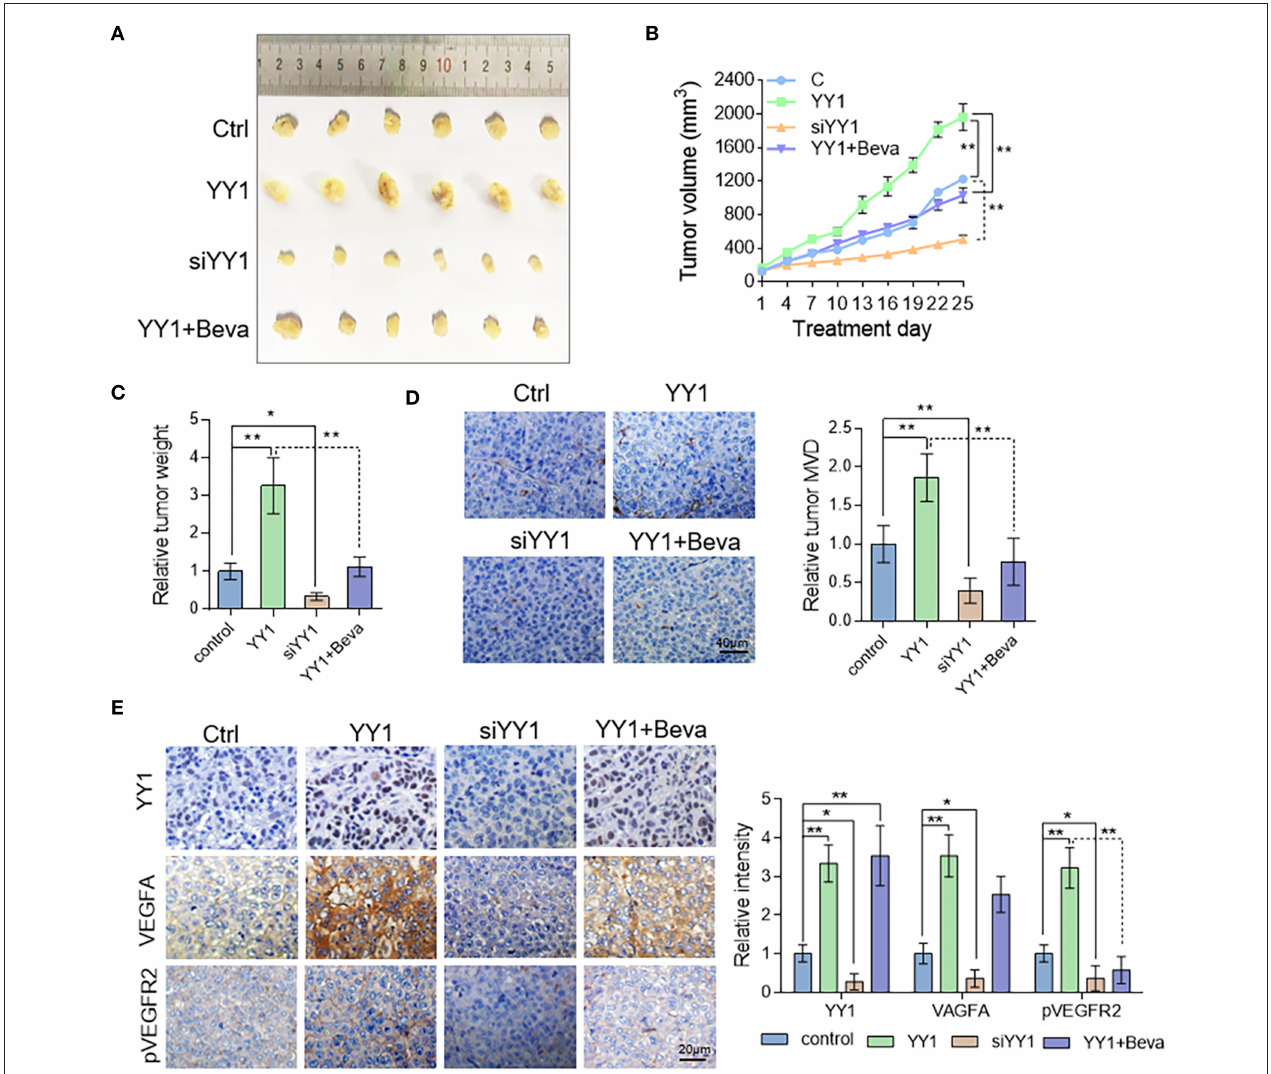
FIGURE 6 | YY1 enhanced tumor vascularization in HCC xenograft model by promoting VEGFA expression. (A) Images of subcutaneous tumors of Ctrl, YY1, siYY1, and YY1 + bevacizumab group mice ( n = 6/per group). (B) Tumor size was measured starting from bevacizumab treatment. (C) Tumor weight in control, YY1 and siYY1 and YY1 + bevacizumab groups. (D) Analysis of MVD on the basis of CD31 staining of tumor tissue. Scale bar = 40 µ m. (E) Immunohistochemical staining of YY1, VEGFA, and pVEGFR2 expression levels in tumor tissue of the Ctrl, YY1, siYY1, and YY1 + bevacizumab groups. Scale bar = 20 µ m. * P < 0.05, ** P < 0.01.